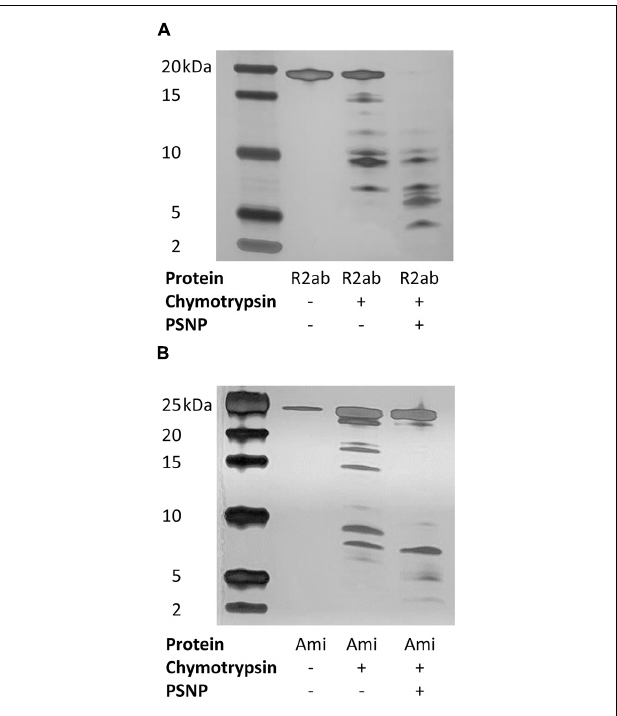
FIGURE 5 | Limited proteolysis of autolysin domains. Representative silver-stained products of chymotrypsin cleavage of R2ab (A) and amidase [Ami, (B) ] domains in the presence and absence of carboxylate functionalized PSNPs. The leftmost lane contains markers, and molecular weights are labeled. Limited proteolysis is more complete in the presence of PSNPs for both proteins, suggesting partial unfolding in the presence of